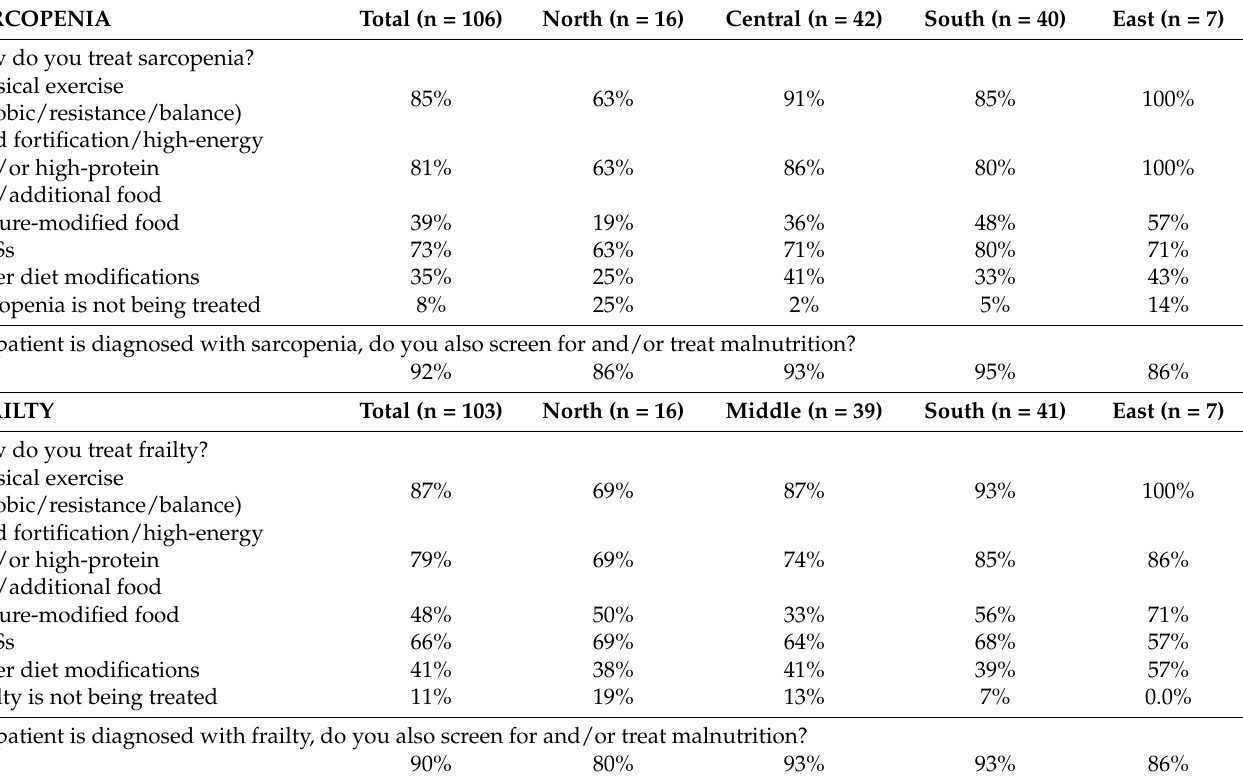
Table 5. Treatment of sarcopenia and